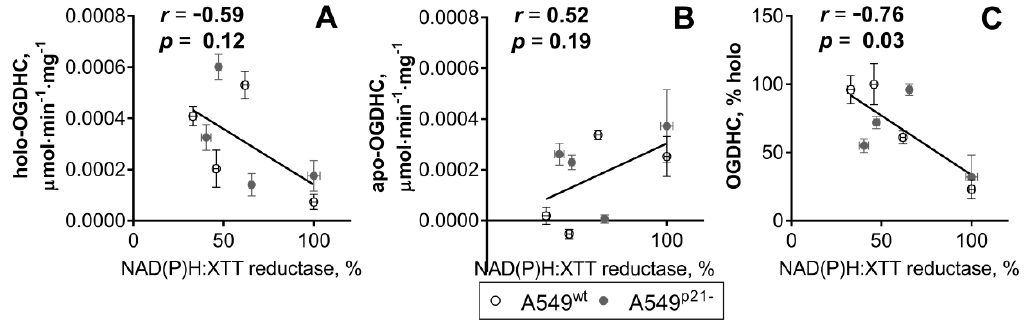
Figure 3. Correlations between the cellular NAD(P)H:XTT reductase activity and the OGDHC partition into the holo- and apo-OGDHC. The data for eight experimental groups including A549 wt and A549 p21- cells under different thiamine/ThDP saturation are used. All datasets successfully passed the D’Agostino & Pearson omnibus normality test. Linear regressions of Pearson’s correlation are presented, with their correlation coefficients ( r ) and p-values ( p ) for statistical significance given on the graphs. ( A ) Correlation between the NAD(P)H:XTT reductase activity and the holo-OGDHC level. ( B ) Correlation between the NAD(P)H:XTT reductase activity and the apo-OGDHC level. ( C ) Correlation between the NAD(P)H:XTT reductase activity and ratio (in %) of holo-OGDHC to total OGDHC.